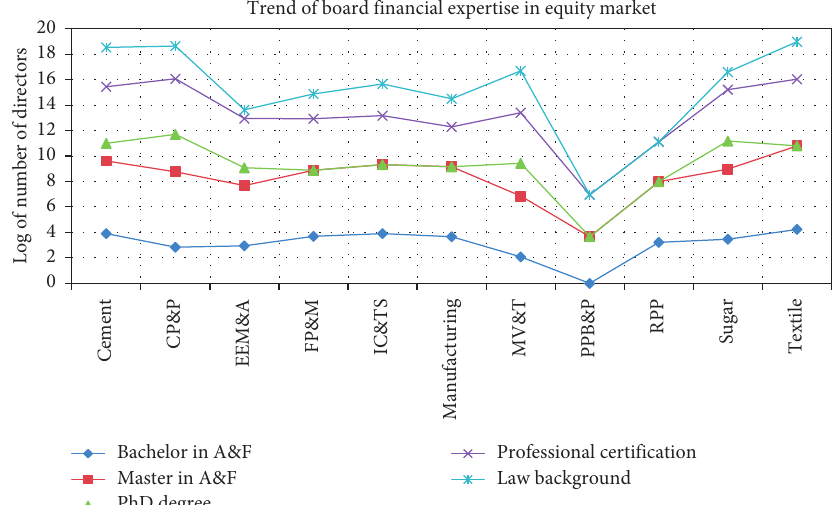
Figure 1: Trend of board financial expertise in Pakistani listed family firms.